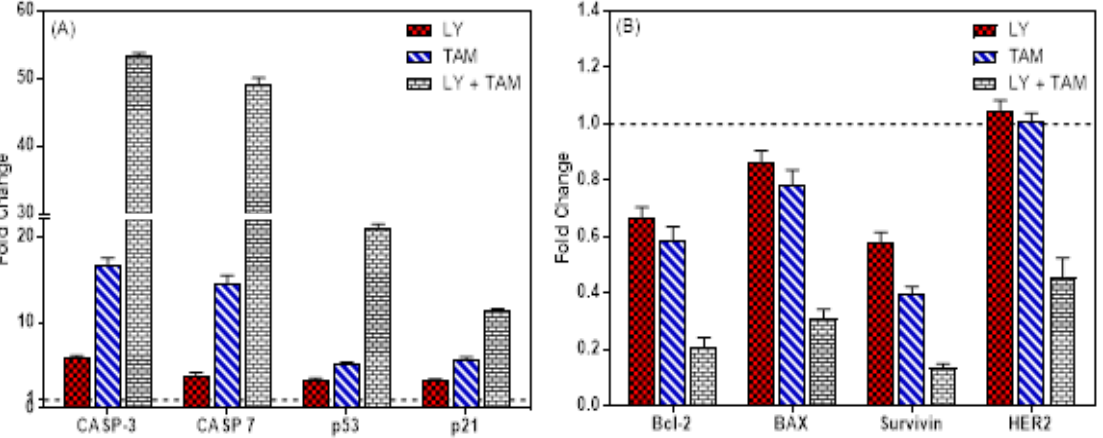
Figure 5. The expression of apoptosis genes in MCF-7 cell after treatment with LY, TAM, and LY + TAM combination for 24 h. The total RNA was extracted and the mRNA levels of upregulated genes ( A ) and downregulated genes ( B ) was quantified using RT-PCR. The data represented the mean of the fold change related to untreated control (fold change = 1 dashed line).